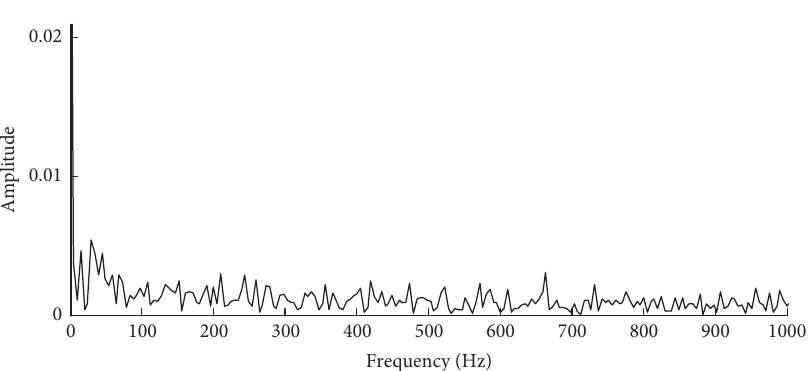
Figure 13: High and low resonance component of inner race fault.